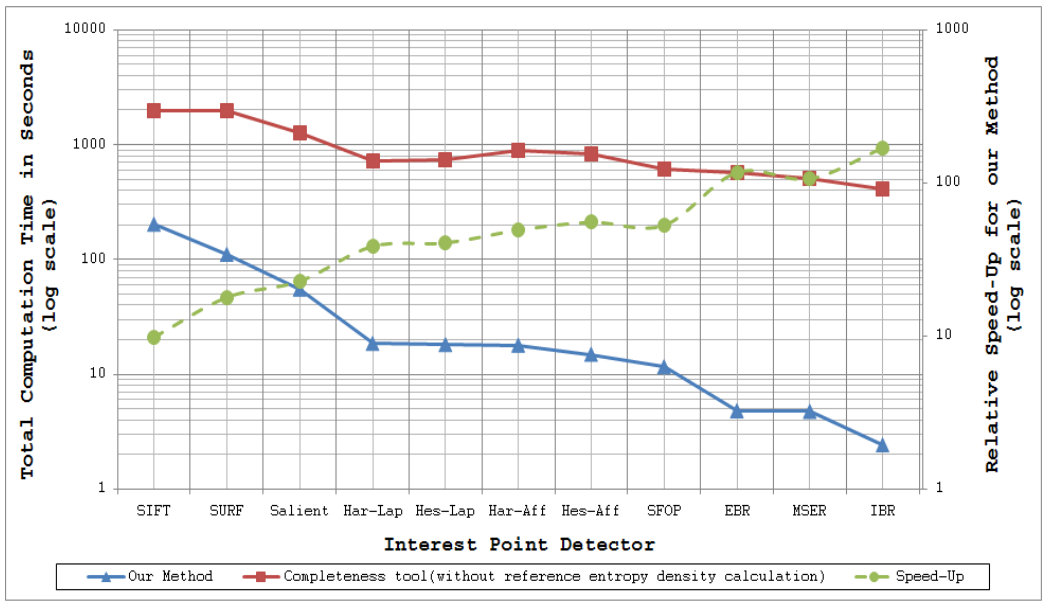
Figure 11. Timing analysis of the proposed coverage method and the Completeness tool [15] for 48 images of the Oxford Datasets [21].